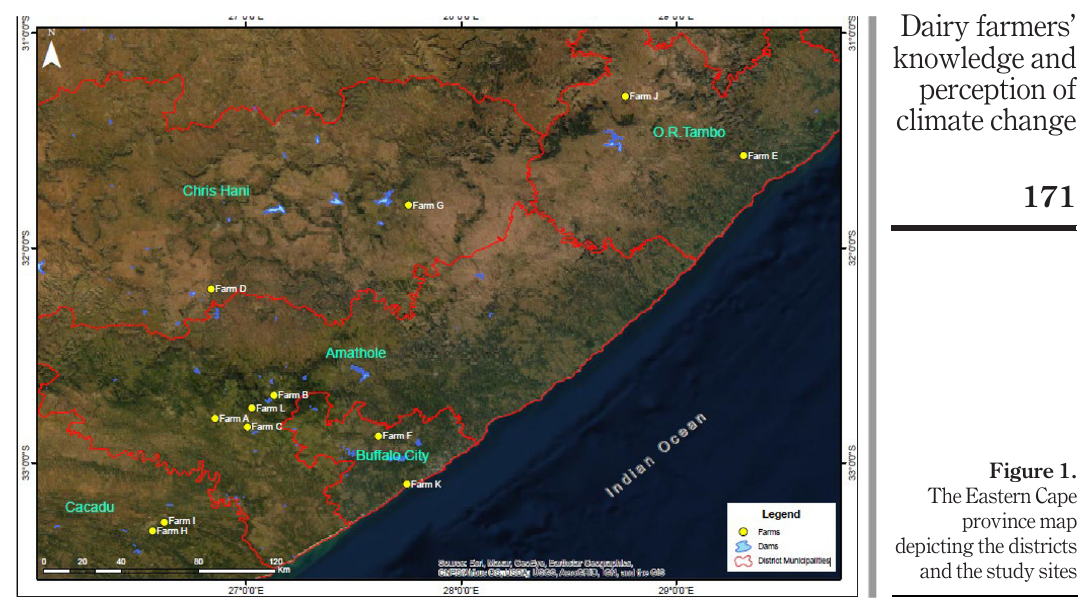
Figure 1. The Eastern Cape province map depicting the districts and the study